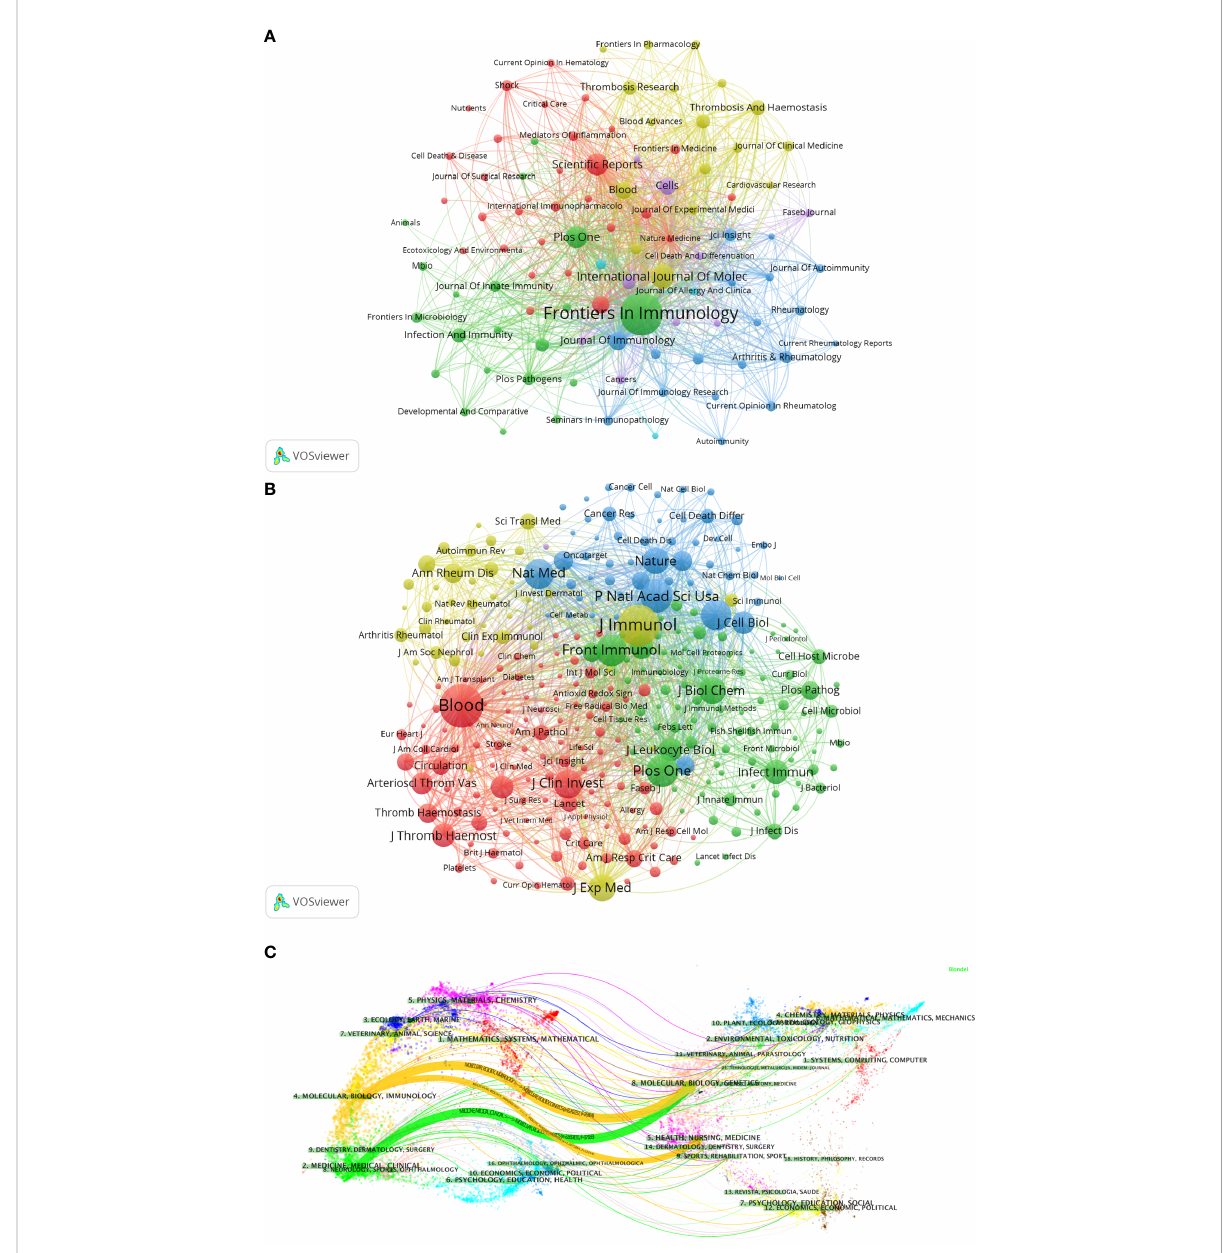
FIGURE 5 Analysis of NETs-related journal. (A) Analysis of collaborative network visualization of journals in VOSviewer. The fi gure shows the journals with more than 10 documents. The nodes in different colors represent the journals in different clusters, and the size of the nodes indicates the frequency of their occurrence. (B) Analysis of collaborative network visualization of journals ’ citations in VOSviewer. The size of the nodes indicates the frequency of their occurrence. (C) The dual-map overlay of journals. Citing journals are on the left, cited journals are on the right, and colored paths indicate citation